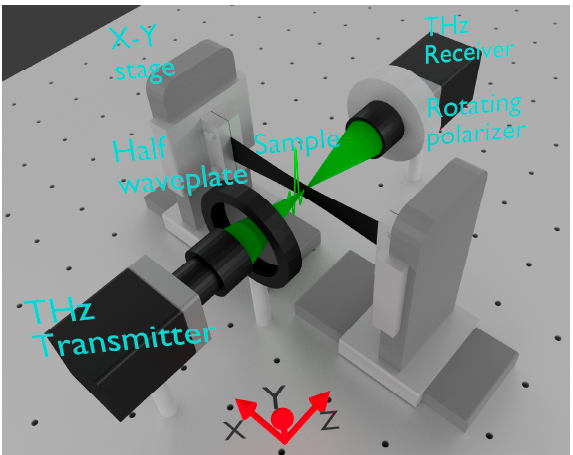
Figure 1. A three-dimensional illustration of the handmade polarization-sensitive terahertz time- domain spectroscopy (PS THz-TDS) system for investigating the optical responses of black rubber composites. This setup enables strain imaging of stretched rubber samples.